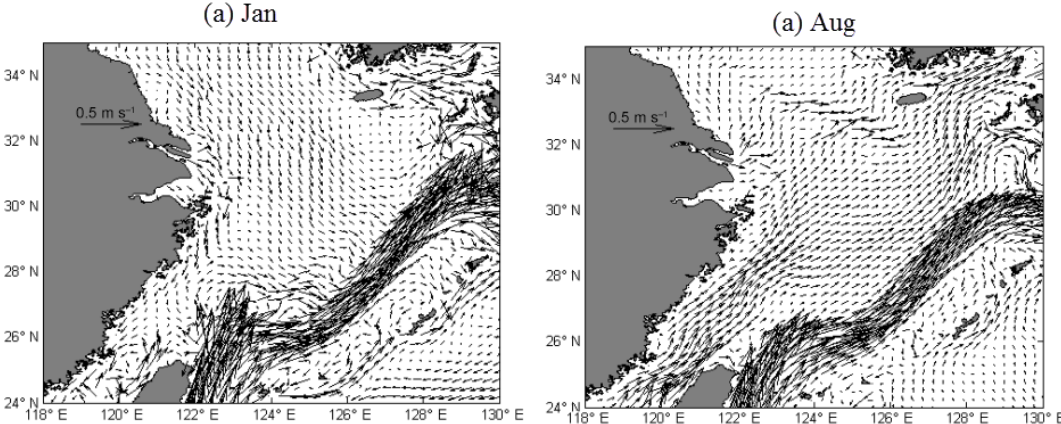
Figure 4. The numerically simulated circulation pattern: (a) January 2011; (b) August 2011.